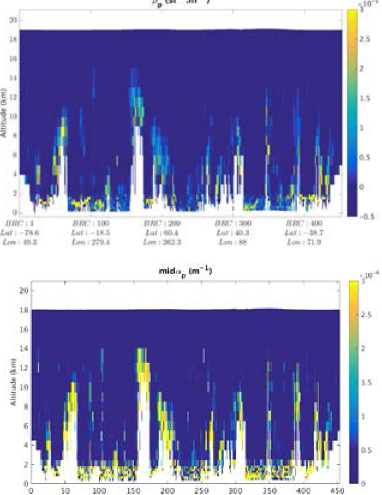
Figure 4: Aeolus L2A product particle backscatter (top panel) and particle extinction (lower panel) coefficient profiles for one orbit, 2 January 2019 (T. Flament, H. Stieglitz).